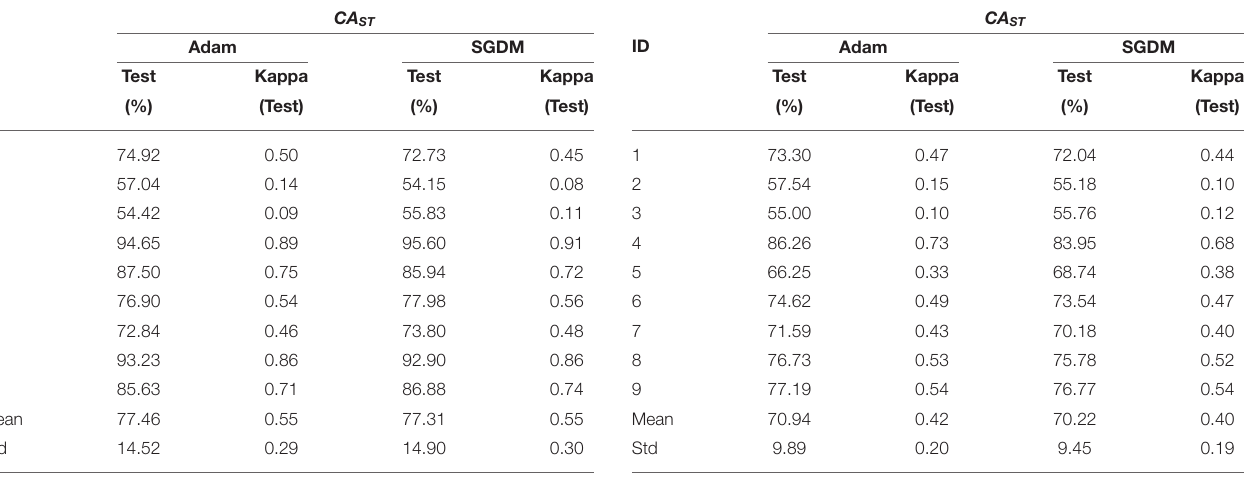
TABLE 6 | Performance of intra-subject learning for single-trial decoding. TABLE 7 | Performance of inter-subject learning for single-trial